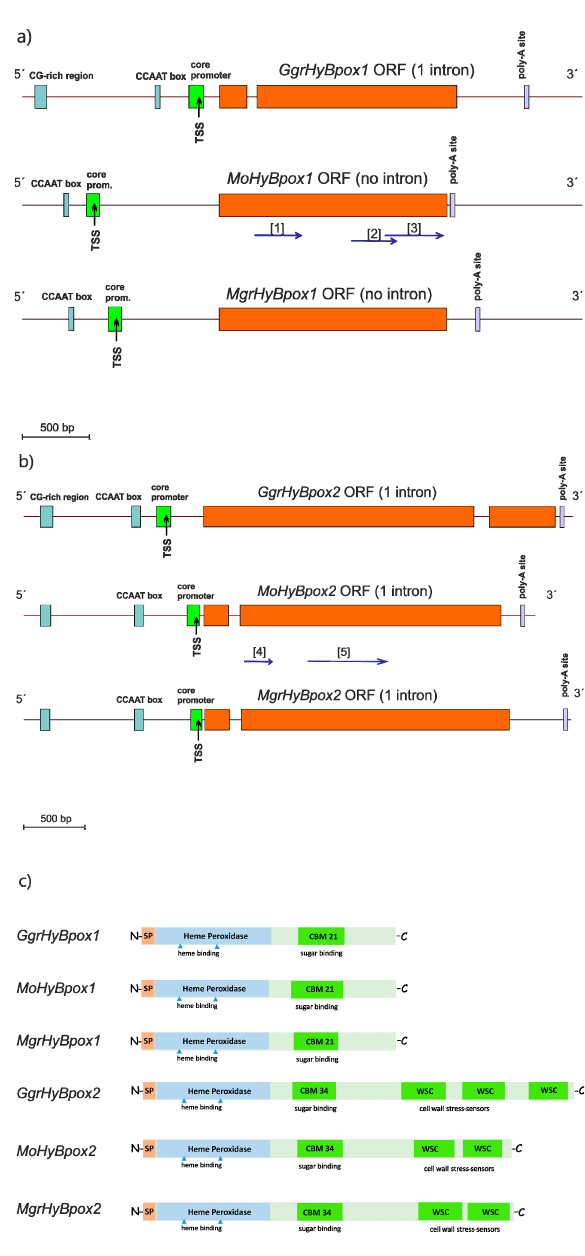
categories and invariant sites and 100 bootstrap replicates. A very similar tree topology was obtained also with the Mr Bayes approach [22] with a relative burn-in of 25% performed over 1,500,000 generations. Numbers in the nodes represent bootstrap values and posterior probabilities, respectively (presented are only values above 33/0.5). All here used abbreviations of peroxidases correspond with RedoxiBase [1] (http://peroxibase.toulouse.inra.fr/).